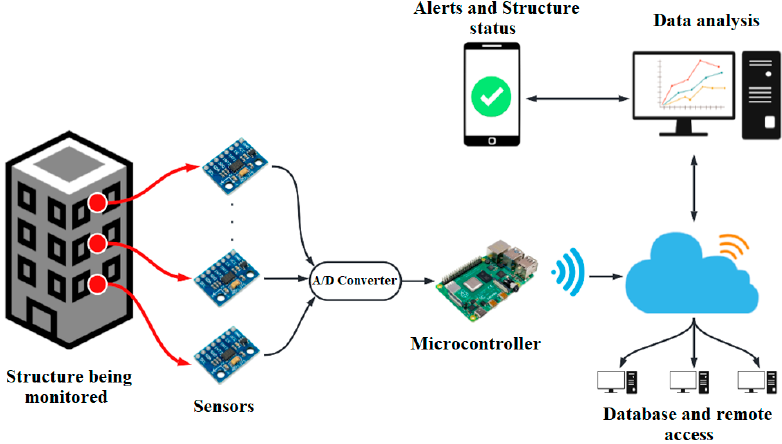
Figure 1. General architecture of SHM systems.